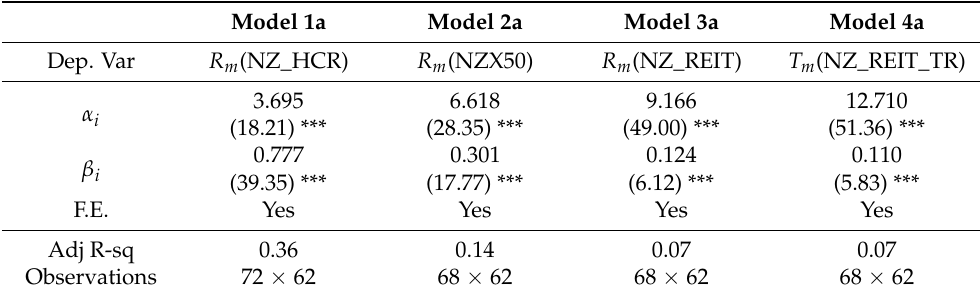
Table 4. Results of the Single-factor CAPM Models.